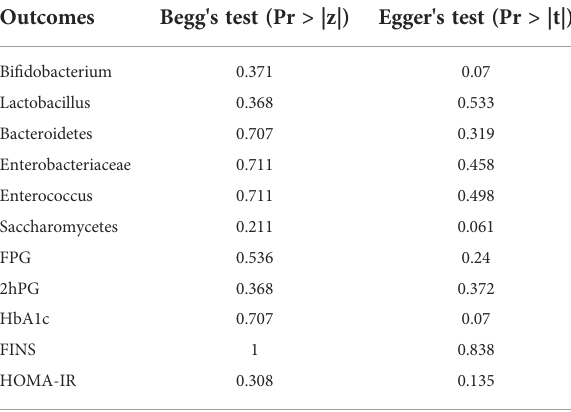
TABLE 5 Summary of data of Pr > |z| and Pr > |t| in Begg ’ s test and Egger ’ s test.